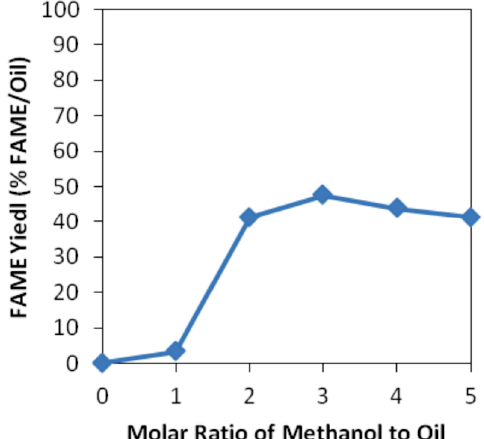
Fig. 6. Effect of lipase concentration on FAME yield (72 h reaction).